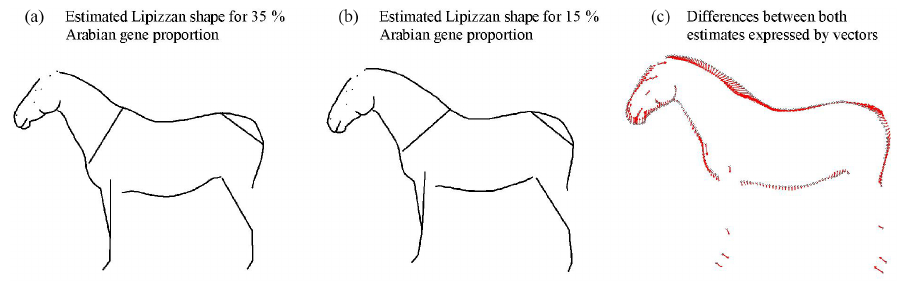
Figure 5. Estimated Lipizzan shapes along the regression curve for the (a) 35% Arabian gene proportion and (b) 15% Arabian gene proportion. The differences in landmark configurations between both estimates are shown in (c) expressed by vectors, which illustrate the shape transitions between the two